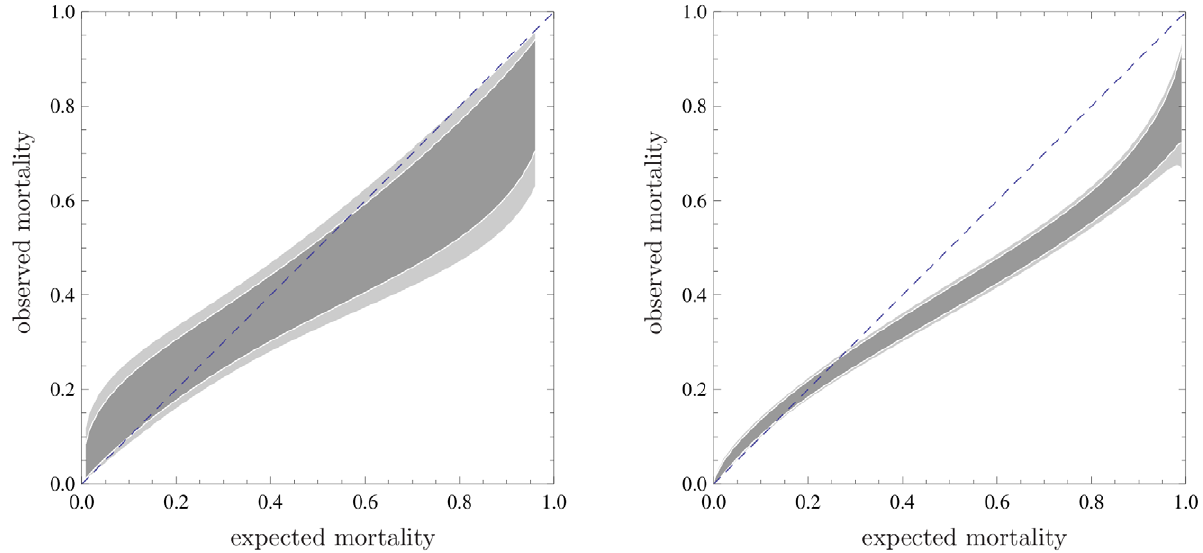
Figure 3. Calibration belts for the two discussed examples at two confidence levels. q ~ 0 : 80 ( dark shaded area ) and q ~ 0 : 95 ( light shaded area ); m f ~ 1 for the first example (left panel), m f ~ 2 for the second (right panel). bisector ( dashed line ). As in Fig. 2, the calibrations bands have been plotted in the range of mortality where data are present. Refer to the caption of Fig. 1 for information about the data sets.